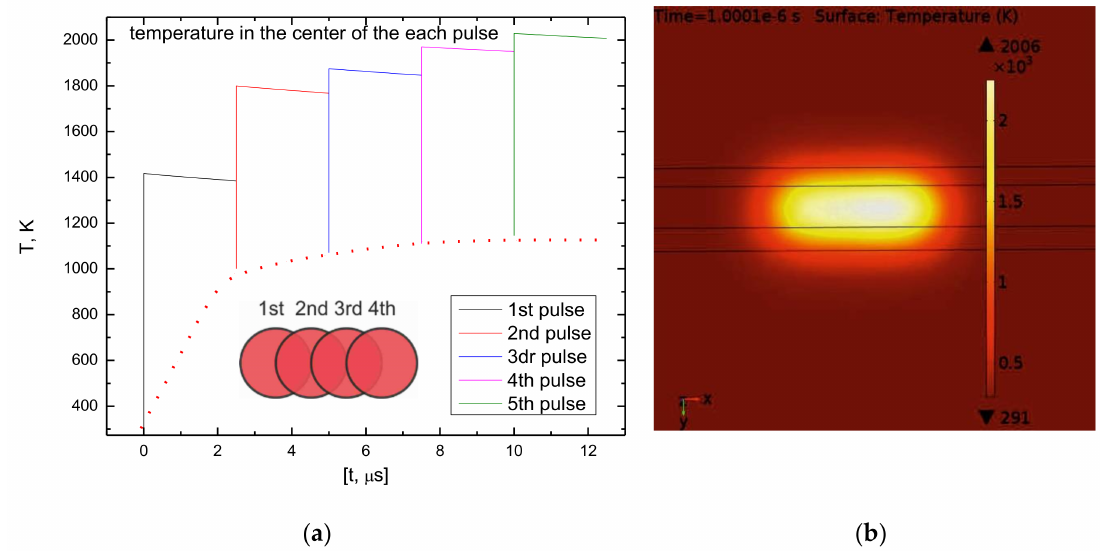
Figure 3. The transient temperature model for conventional scanning: ( a ) in the centre of the pulse; ( b ) the temperature distribution on the surface after 4th